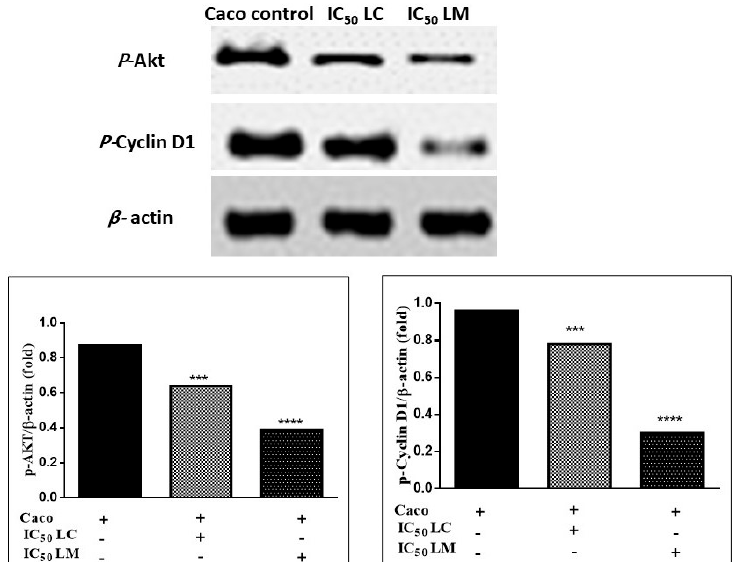
Figure 8. Western blot analysis of L. camara and L. montevidensis extracts in Caco cells. Results were expressed as mean ± SE, ( n = 3). *** p < 0.001 and **** p < 0.0001 is considered significant compared to the Caco control untreated cells. Bands were relatively expressed to β -actin protein (internal control) (Figures S7 and S8) by western blot analysis.